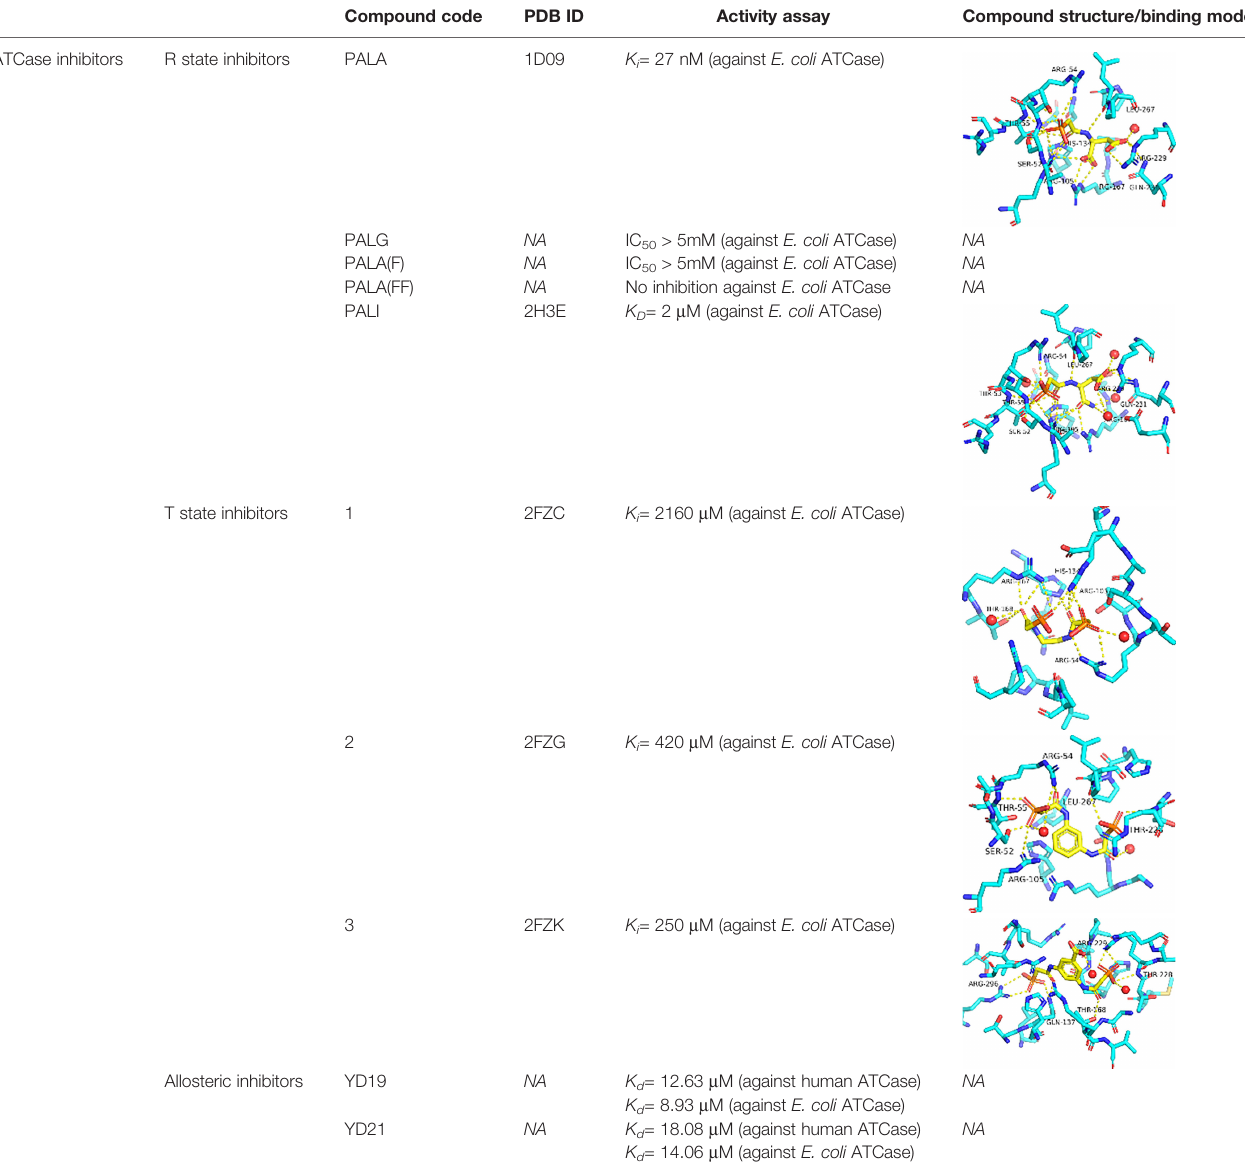
TABLE 1 | A table summarizing the ATCase inhibitors described in this review. Compound